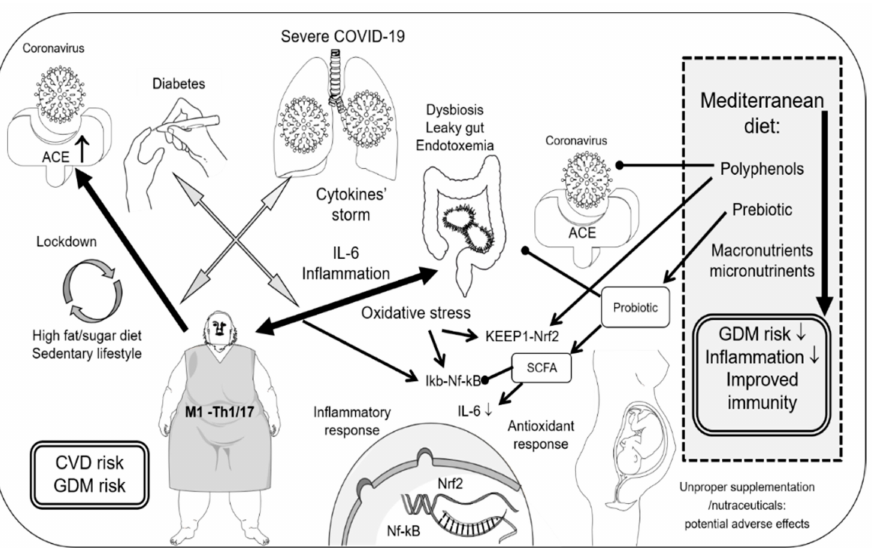
Figure 1. COVID-19, diabesity, and MedDiet interactions. ACE: Angiotensin-Converting Enzyme; COVID-19: Coronavirus Disease 2019, CVD: cardiovascular disease; GDM: Gestational Diabetes Mellitus; KEAP1: Kelch-Like ECH-Associated Protein 1; I- κ B: Kappa b inhibitor; IL: interleukin; Nrf2: Nuclear Factor Erythroid-Derived 2-Like; SCFA: Short-Chain Fatty